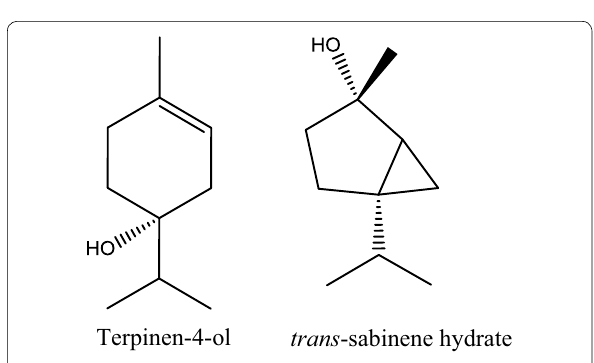
Fig. 2 Major identified compounds in OV EO